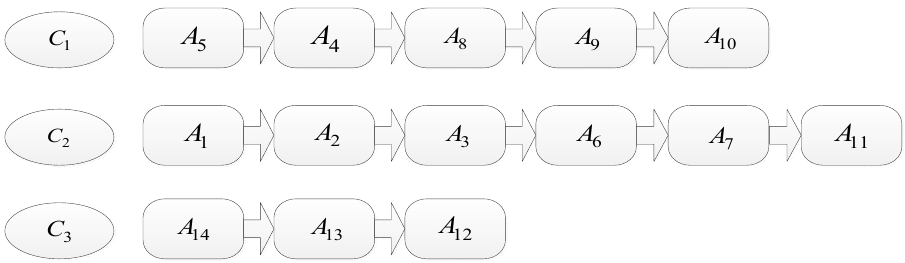
Figure 9. The taxi paths of A 1 , A 5 and A 14. 0